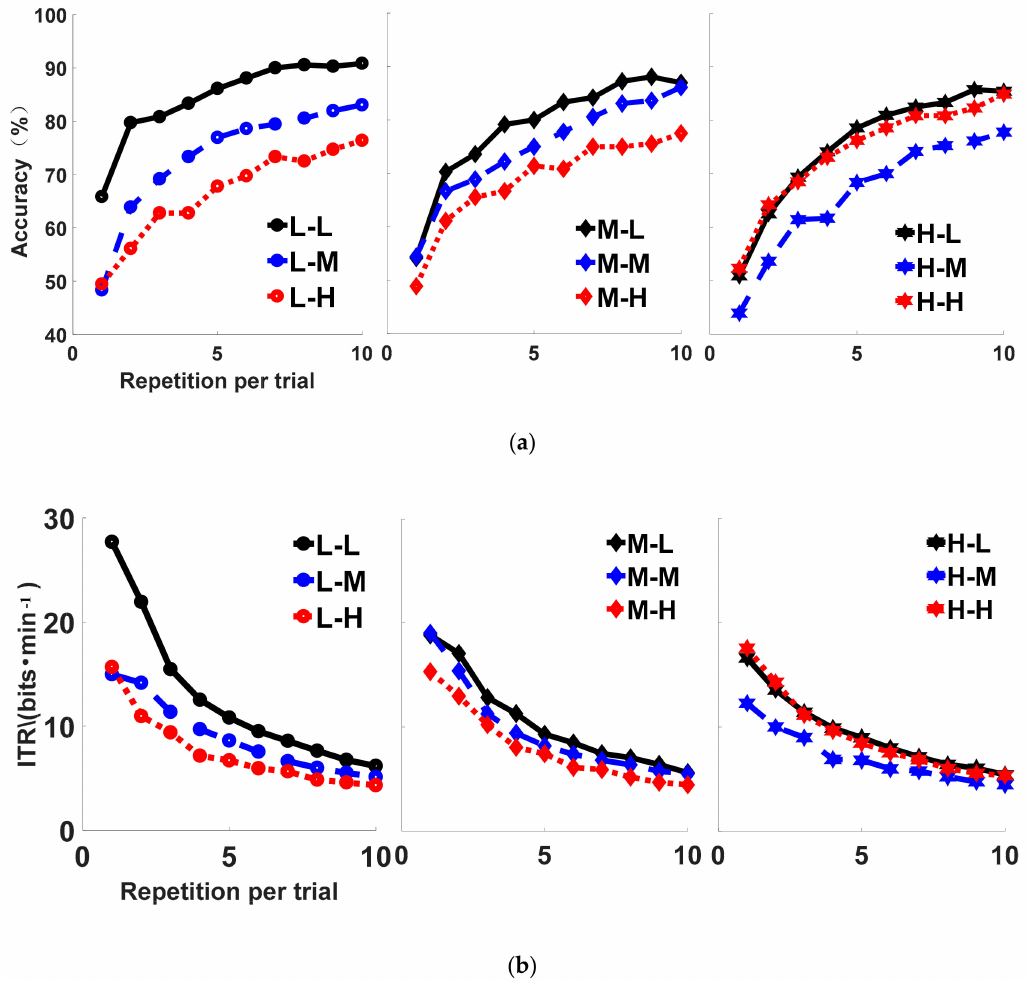
Figure 6. The changes of accuracy and ITR under di ff erent mental workloads: ( a ) The changes of accuracy under di ff erent mental workloads; ( b ) The changes of ITR under di ff erent mental